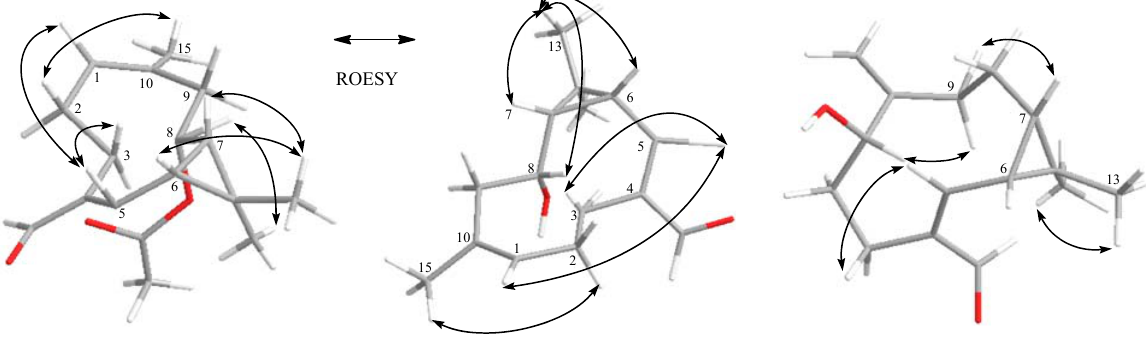
Figure 2. Key ROESY correlations of compounds 1 – 3